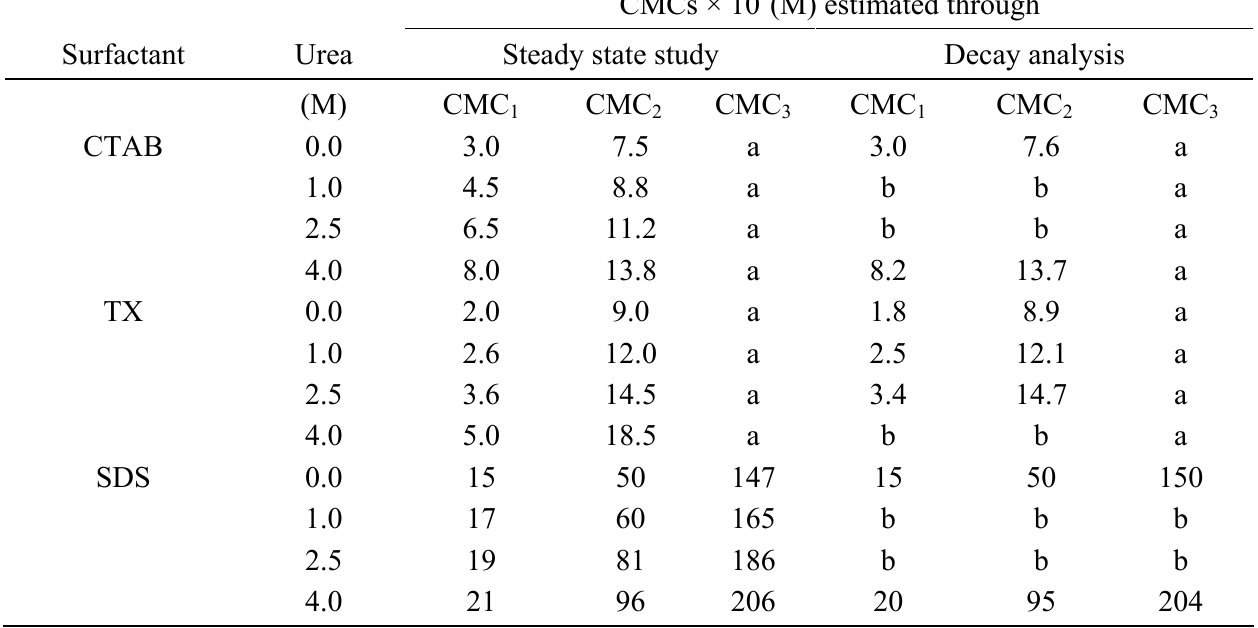
Table 6. Estimated CMCs for aqueous CTAB, TX and SDS systems in absence and in the presence of